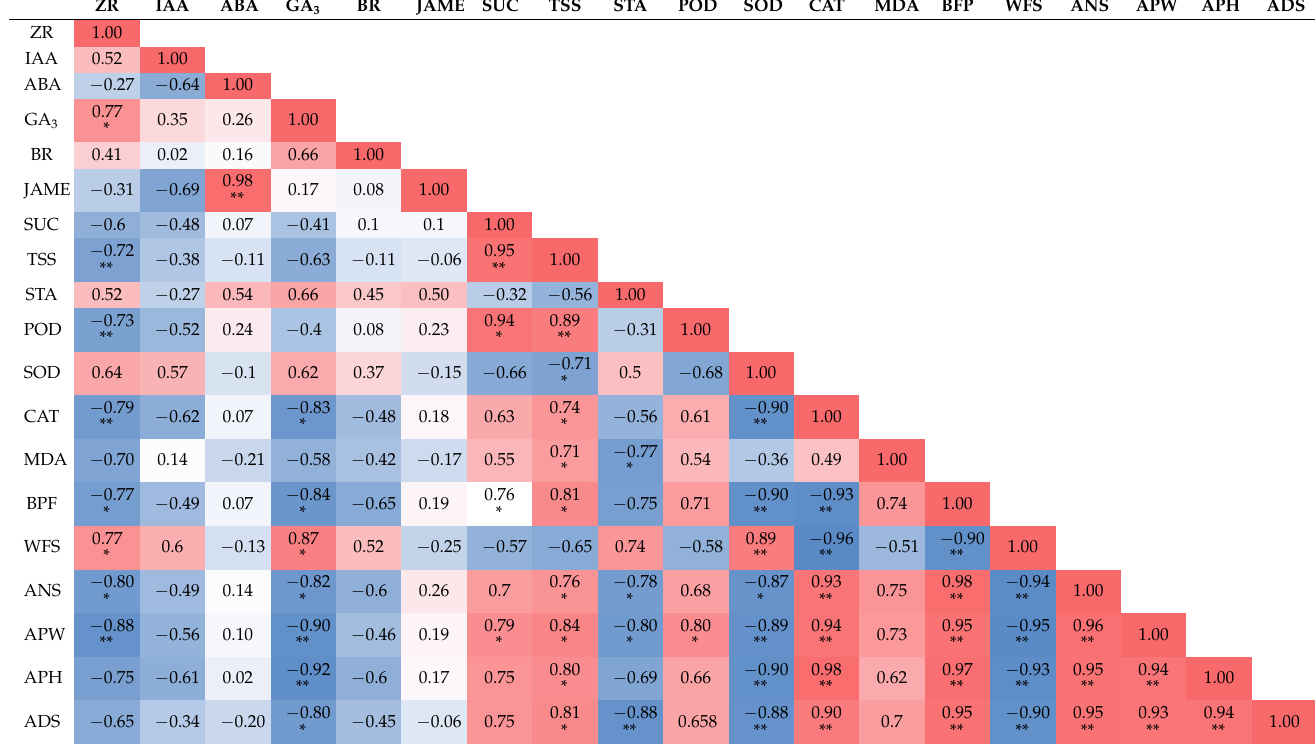
Table 1. Correlation analysis of related crucial indices.